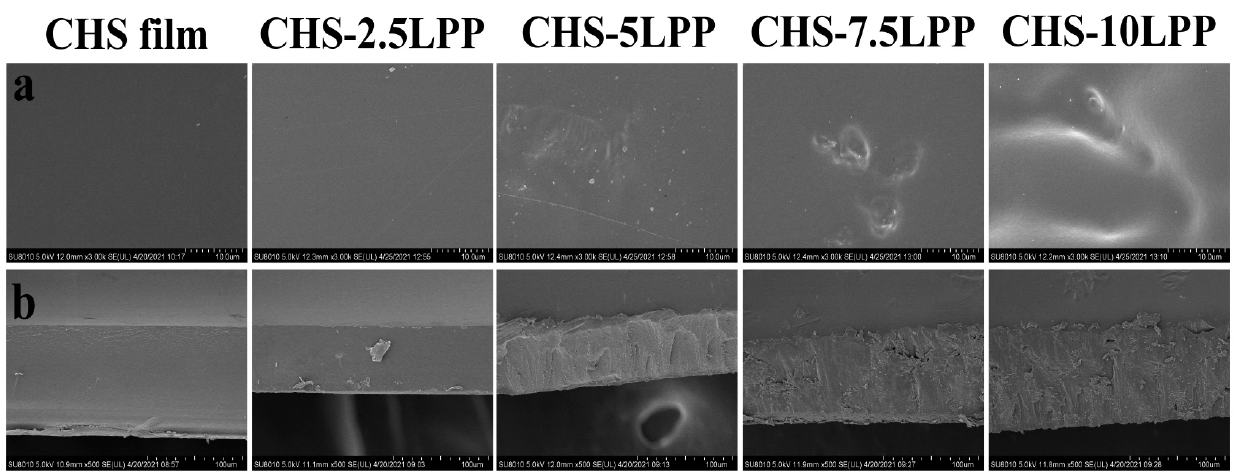
Figure 2. SEM images of the surface ( a ) and cross-section ( b ) of the films. The FT-IR spectra of the LPP and films are shown in Figure 3. The spectra for LPP shows characteristic bands of phenolic compounds at 1654, 1546, and 1060 cm − 1 corre- sponded to C=O stretching vibration, C=C stretching of aromatic ring, and C-O deformation of aromatic ring [13]. In FT-IR spectra of CHS film, the broad band at about 3188 cm − 1 represented stretching vibration of N-H and O-H. The characteristic bands at 1346, 1407, 1537, and 1631 cm − 1 corresponded to C-N stretching, C-H bending, N-H bending, and C-O stretching of amide group, respectively [36]. The addition of LPP did not significantly change the FT-IR spectra of CHS films, while the FTIR spectra of CHS-LPP films had similar profiles. Zhang et al. [37] also found that the FTIR spectra of the CHS film did not change significantly after adding mangosteen rind powder, confirming that mangosteen rind powder and the CHS matrix have good compatibility. However, after adding LPP to the CHS film, the positions of the peaks at 3188 and 1537 cm − 1 shifted. The changes in the peak position were due to the formation of intermolecular hydrogen bonding interactions between the hydroxyl/amino groups of CHS and the hydroxyl groups of polyphenols [13]. The XRD patterns of the films and LPP are shown in Figure 4. The XRD pattern of LPP has a broad peak around 22 ◦ , indicating that LPP was in an amorphous state. Different from LPP, CHS film exhibited a semi-crystalline state with four obvious diffraction peaks at 2 θ = 8.31, 11.33, 18.08, and 22.76 ◦ , which correspond to the crystal plane of (200), (201), (202), and (311), respectively [13,36]. The peaks at 8.31 and 11.33 ◦ were the hydrated crystallite structure formed by the integration of water molecules in the lattice, and the peak at 18.08 ◦ was attributed to the regular lattice of CHS [38]. After adding LPP to the CHS film, the intensity of the diffraction peaks and the crystallinity of the films were reduced, and the position of the diffraction peak was slightly shifted. This was due to the formation of intermolecular hydrogen bond interaction between LPP and CHS, which interferes with the assembly of CHS into semi-crystal structure